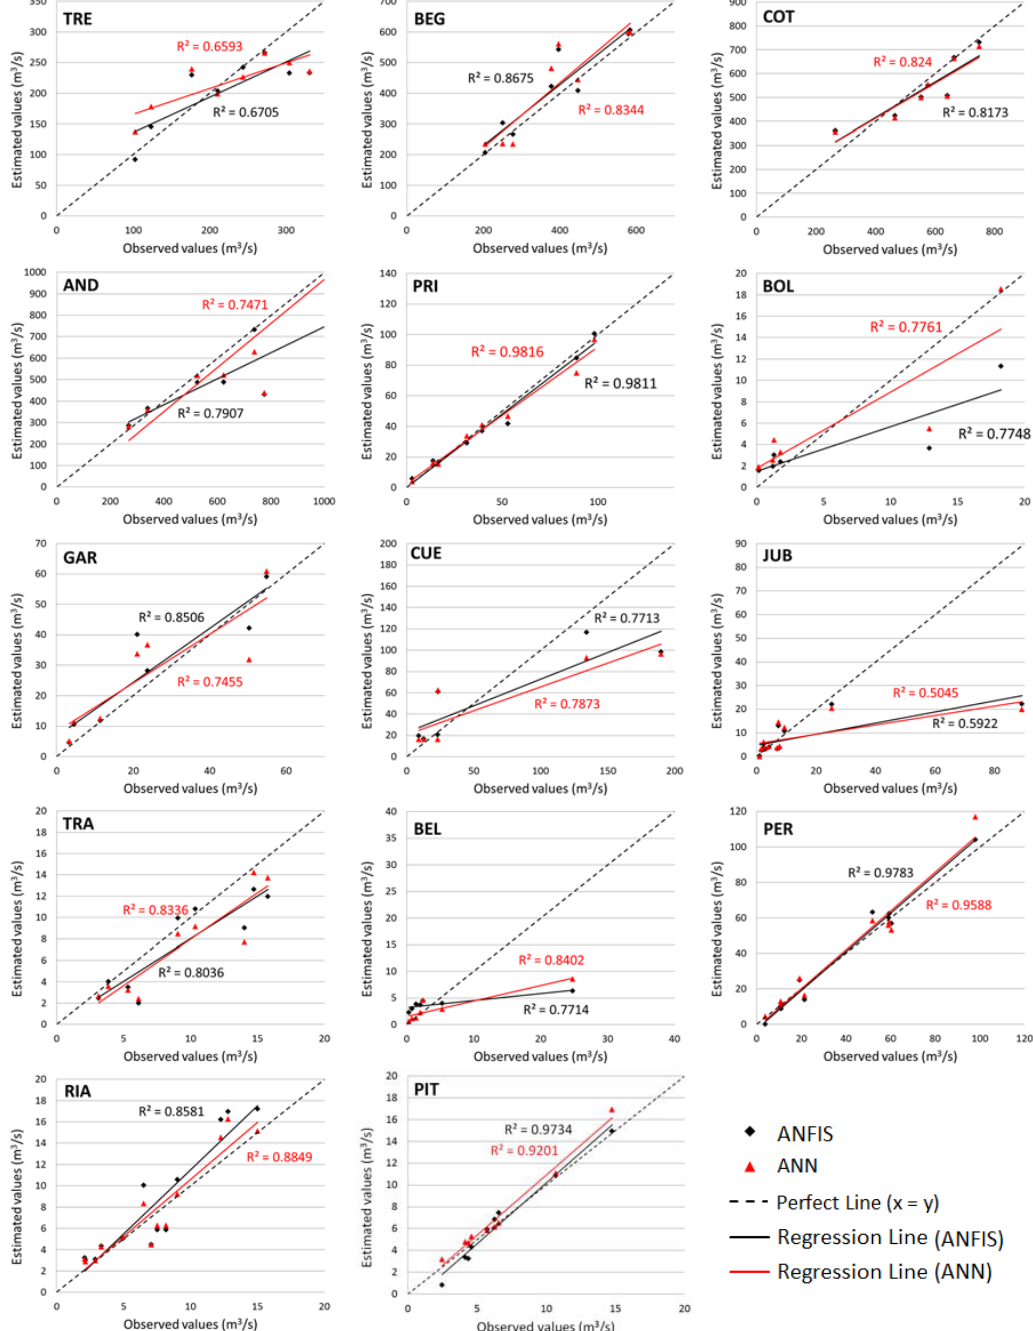
Figure 3. Scatter plots of observed instantaneous peak flow (IPF) (m 3 /s) and the estimated IPF (m 3 /s) obtained with ANN versus ANFIS for basins (test phase). The letters on the top left of each subfigure show the basin codes (see Table 1).